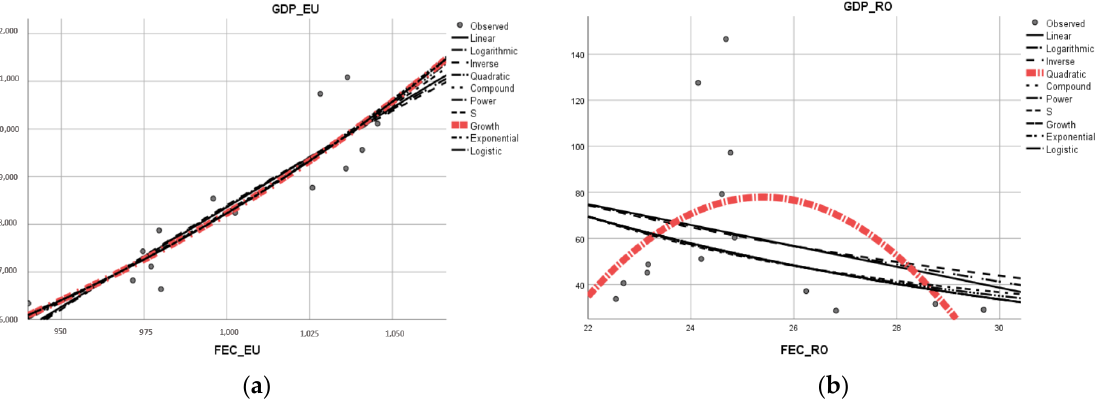
Figure 4. The curve estimation regression models of GDP as a function of FEC (1995–2008): ( a ) EU; ( b ) RO.